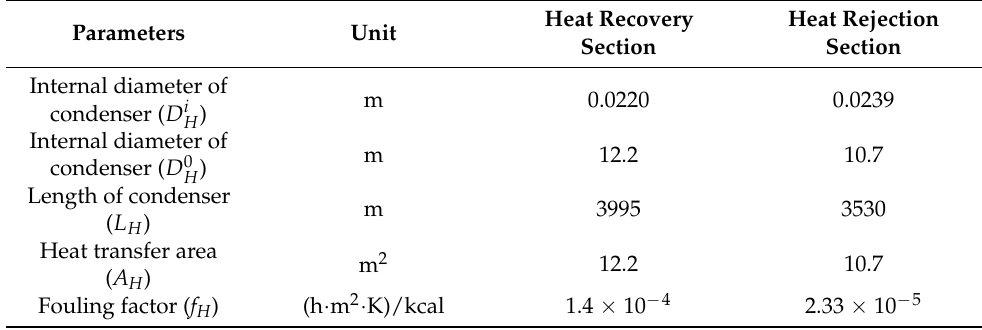
Table 2. Flash chamber parameters of the MSF system.